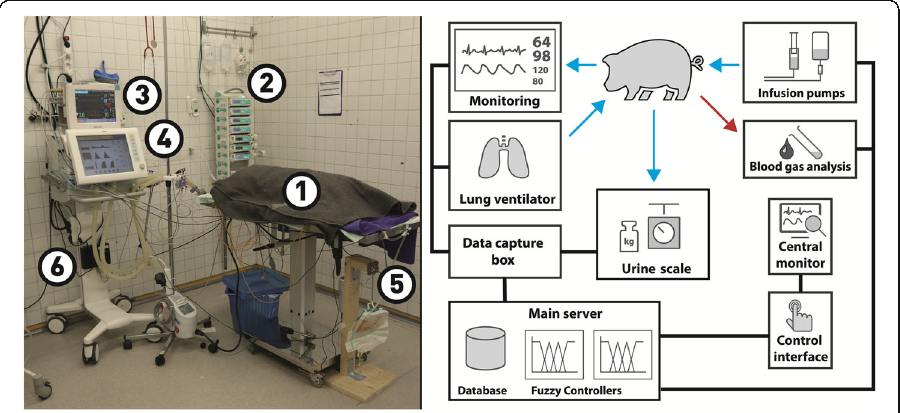
Fig. 1 Used experiment setting (left: 1 pig, 2 infusion pumps, 3 monitoring, 4 lung ventilator, 5 urine scale, 6 data capture box) and schematic illustration